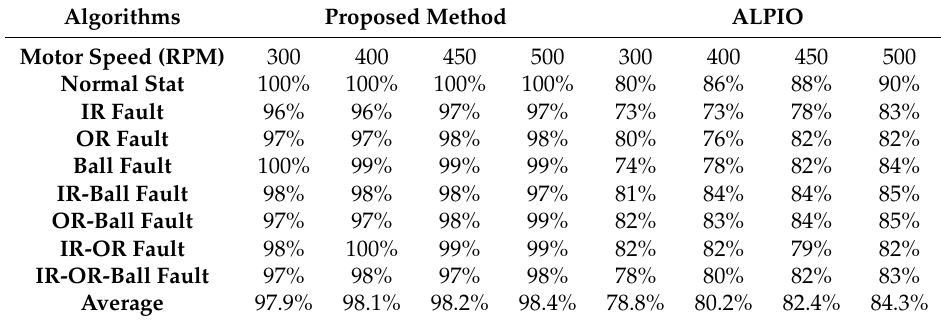
Table 9. Fault diagnosis results for various motor speeds using the proposed method and ALPIO (crack size=6